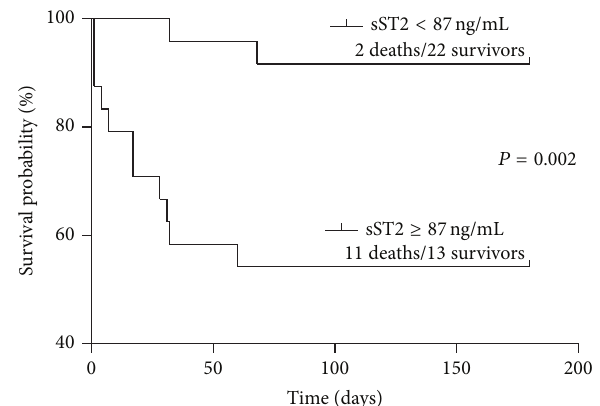
Figure 8: Kaplan-Meier survival curve showing survival probability of 48 patients with hepatitis B virus-related acute-on-chronic liver failure stratified into two groups according to plasma sST2 concen- tration at week